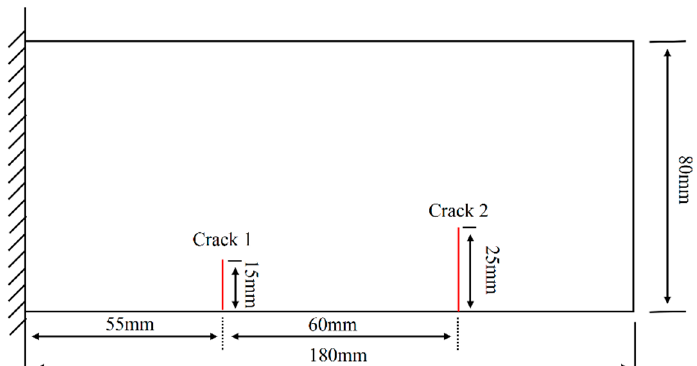
Figure 2. The geometry of a damaged plate structure.